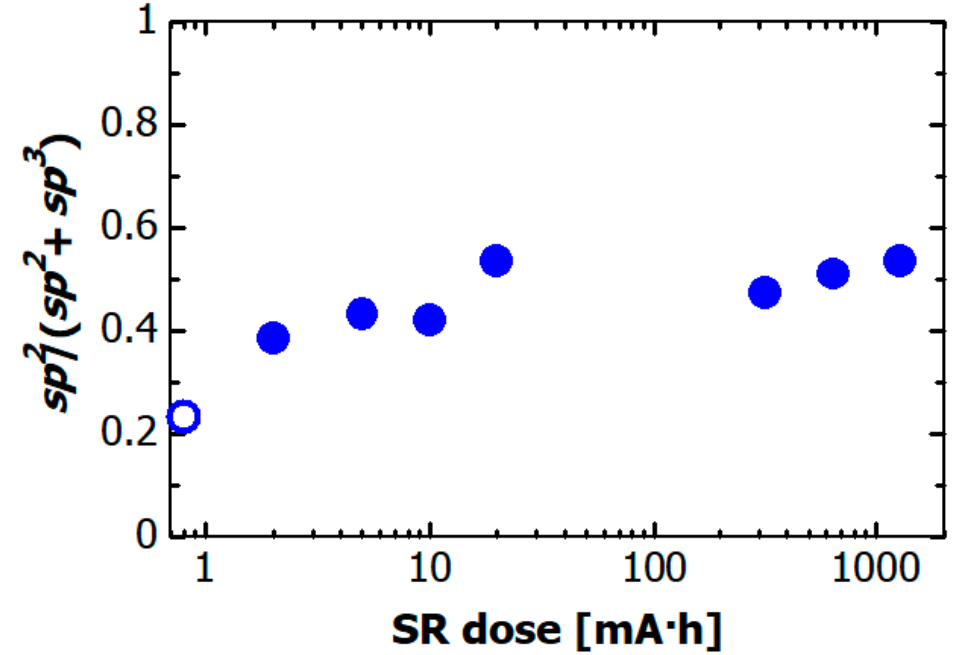
Figure 10. Dependence of the sp 2 /(sp 2 + sp 3 ) ratio in hydrogenated Si-DLC film on the SR dose. The open circle indicates sp 2 /(sp 2 + sp 3 ) ratio of hydrogenated Si-DLC film before SR irradiation.